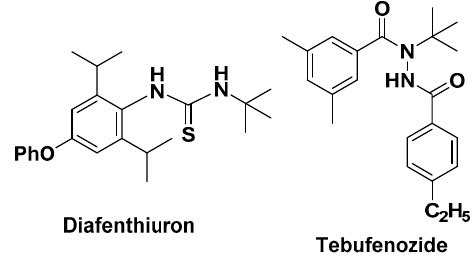
Figure 3. The structures of diafenthiuron and tebufenozide.